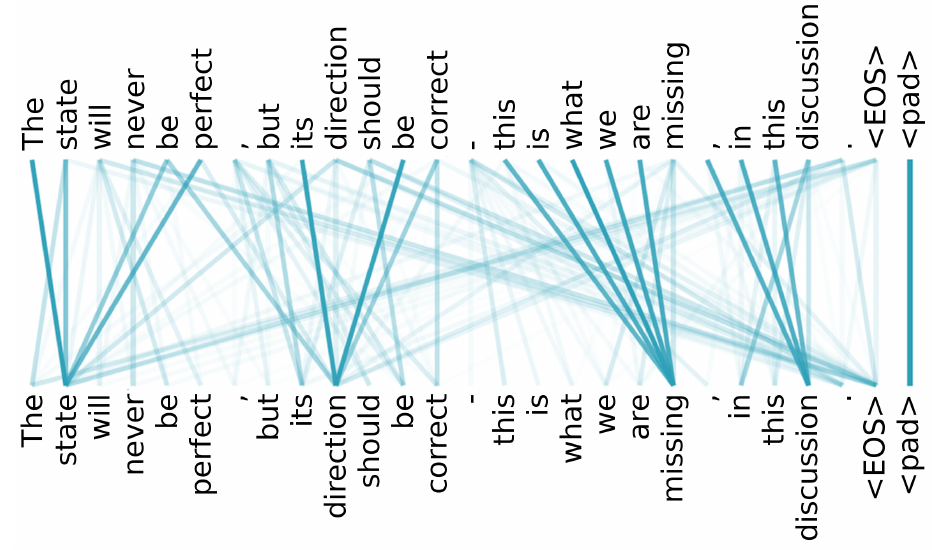
Figure 6. A visualization of a learned self-attention head on a sentence. The visualization shows learned relations between the words this self-attention head has learned. Each head learns a different kind of relations between the